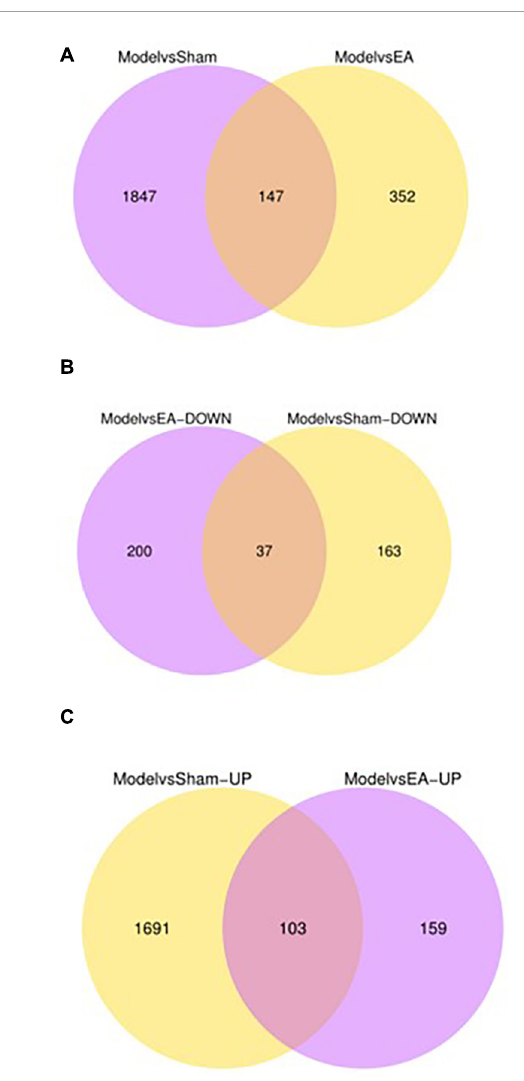
FIGURE6 Number of DEG and intersecting genes in each group. (A) The purple circle represents the amount of DEG between the model group and the sham group. The yellow circle represents the amount of DEG between the model group and the EA group. (B) The purple circle represents the amount of down-regulated DEG between the model group and the EA group. The yellow circle represents the amount of down-regulated DEG between the model group and the sham group. (C) The purple circle represents the amount of up-regulated DEG between the model group and the EA group. The yellow circle represents the amount of up-regulated DEG between the model group and the sham group. Overlapping regions represent the intersecting gene between two comparable groups.